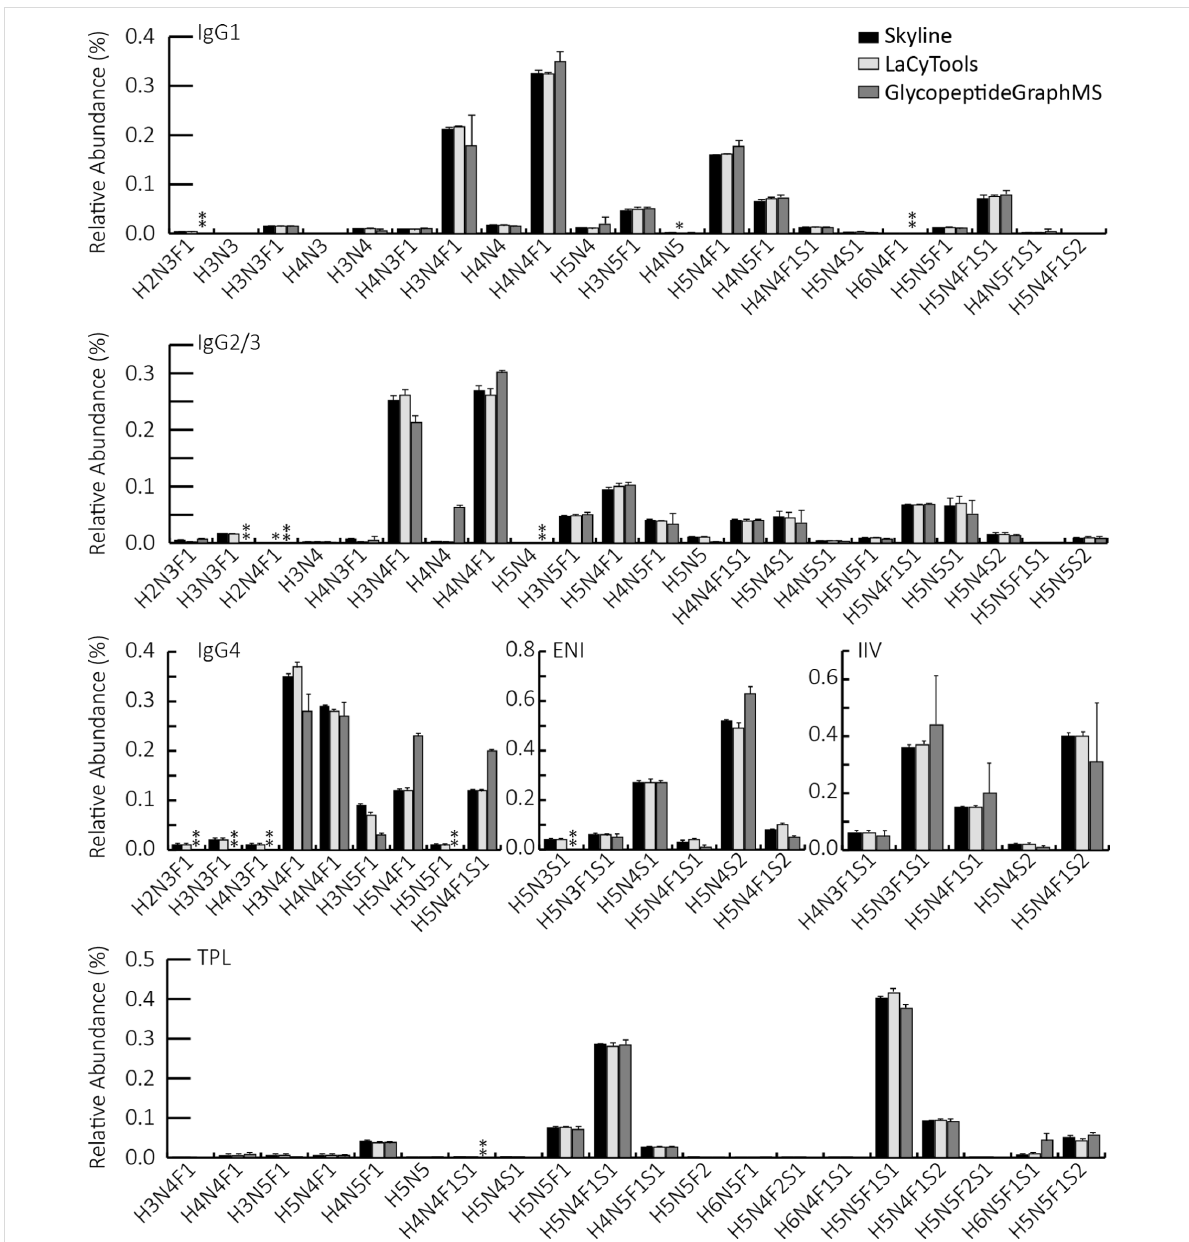
Figure 4: Comparison of quantification results obtained by manual integration of EICs in Skyline (black), automated integration of summed MS spec- tra in LaCyTools (light gray), and GlycopeptideGraphMS (dark gray). Error bars represent standard deviation of MS1-only measurements ( n = 4 for LacyTools and Skyline; n = 3/4 for GlycopeptideGraphMS; in all detected replicates, n was at least 3. The first injection was excluded for all tools due to RT shifts and increased standard deviations). *: Did not pass the analyte curation (LaCyTools). **: Was not identified in at least 3 technical repli- cates